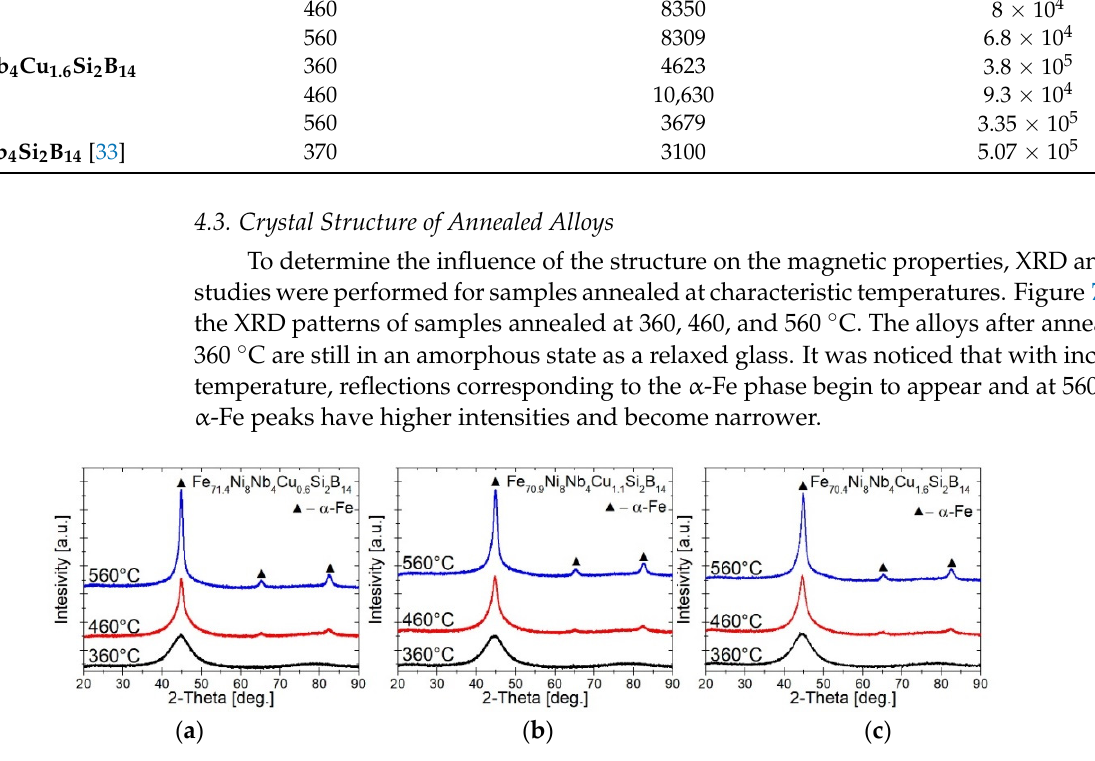
Figure 7. XRD patterns of Fe 71.4 Ni 8 Nb 4 Cu 0.6 Si 2 B 14 ( a ), Fe 70.9 Ni 8 Nb 4 Cu 1.1 Si 2 B 14 ( b ) and Fe 70.4 Ni 8 Nb 4 Cu 1.6 Si 2 B 14 ( c ) annealed at 360 °C, 460 °C, and 560 °C.